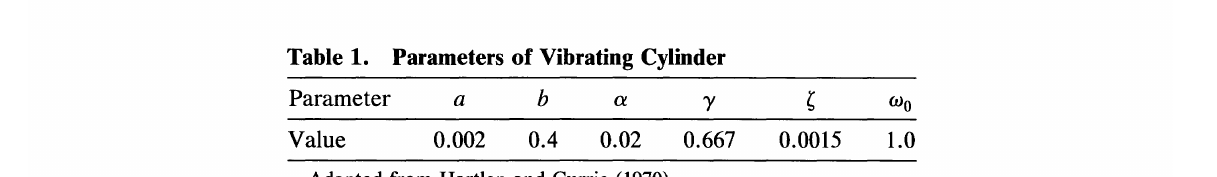
Table 1. Parameters of Vibrating